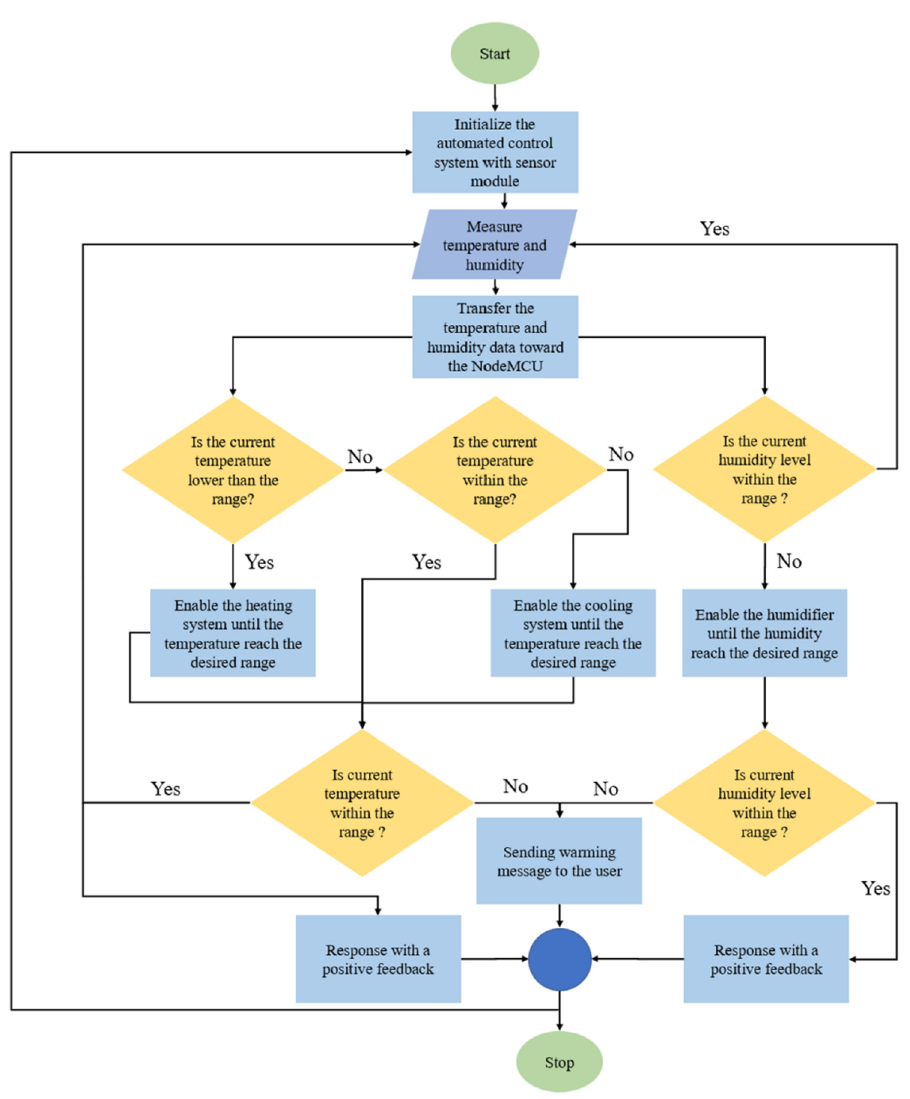
Figure 4. The flow chart of the automated temperature and humidity control system.